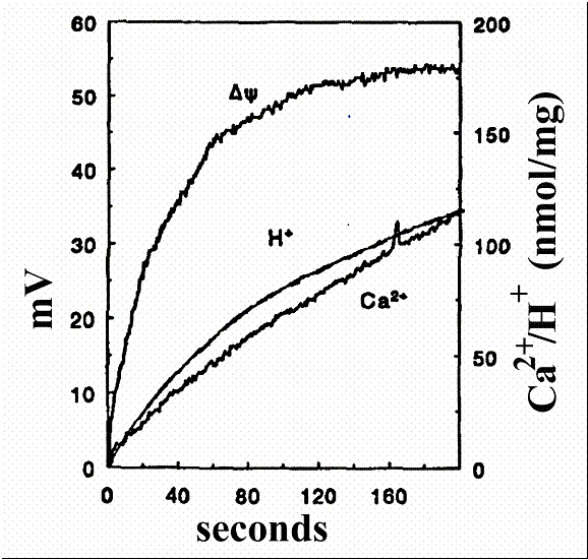
2+ uptake, H + countertransport and development of transmembrane electrical potential in reconsti- tuted SERCA proteoliposomes. The proteoliposomes were placed in a neutral pH medium, containing 100 mM K2SO4, 50 microM CaCl 2 , and color reagents for detection of Ca 2+ , pH and electro- chemical gradients. The reaction was started by the addition of 0.2 mM ATP, and followed by differential absorption spectrometry.